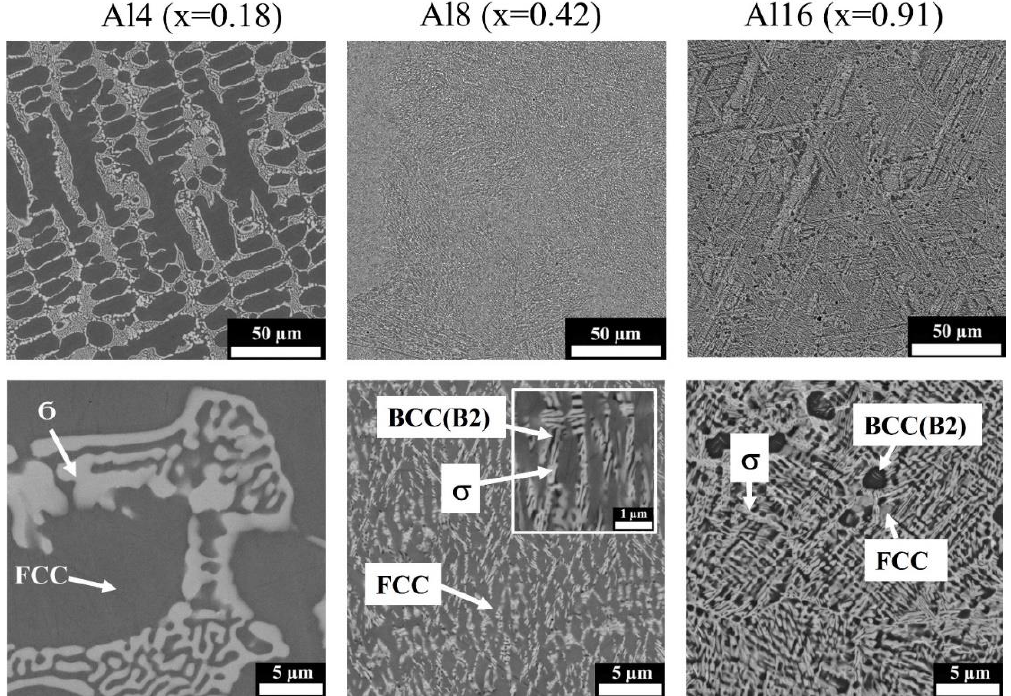
Figure 2. SEM microphotographs of the Al4, Al8, and Al16 alloys. σ -phase — the lightest, BCC(B2) — the darkest, and FCC — grey structural components.